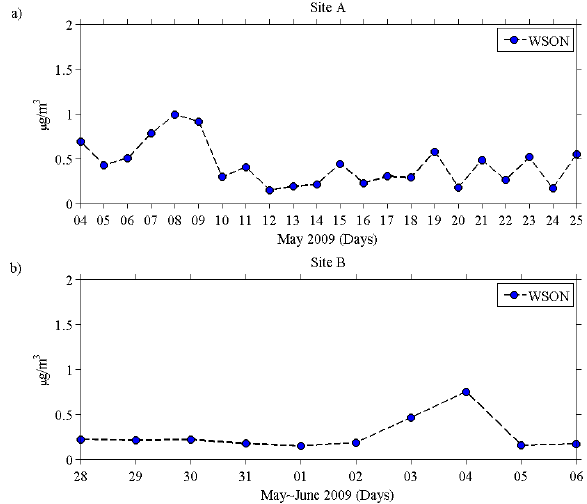
Figure 12 : Daily composition of water soluble organic nitrogen (WSON) Site A (a) and Site B (b). Similar peak in WSON concentration is also observed for Site B associated with pollution episode.